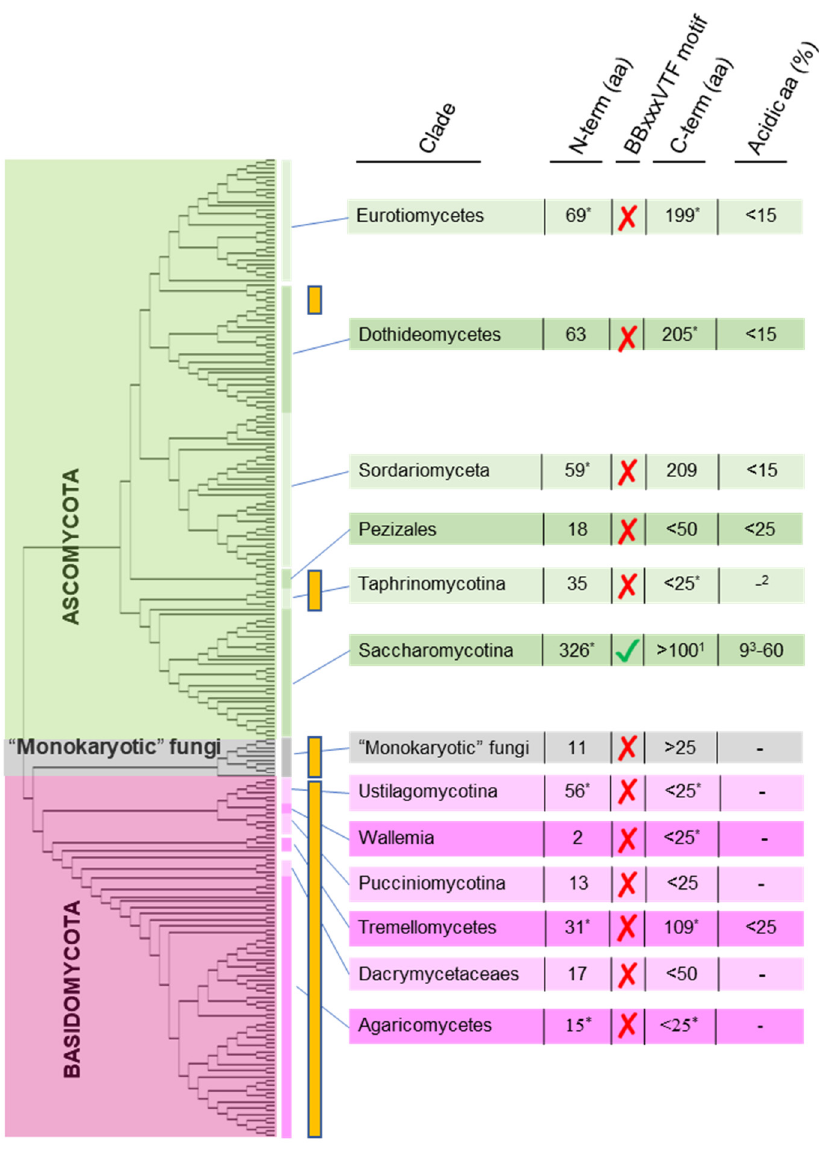
Figure 4. Structural features of Hal3/Cab3-like proteins in fungi. Phylogenetic tree of set of fungal species analyzed in [58]. The vertical orange bars denote clades with organisms with a monomeric PPCDC. The number of N- and C-terminal amino acids were calculated considering, as a central core, the cl19190 domain and excluding proteins in which other domains were identified in these extensions. The NCBI’s Batch Conserved Domain Search tool [59] was used to identify the location of the predicted domains in the output of the BLAST analysis for each specified family. Numbers in the figure indicate the average values. A threshold limit of at least 50 residues was required to cal- culate the percentage of acidic residues. (*), Clades including organisms with other domains identi- fied in the N- or C-terminal regions (not considered for calculation). (1) Heterogeneous values rang- ing from nine to 480 residues due to the values obtained in a few species included in the Trichospo- ronaceae family (see Table 1); (2) in the genus Schizosaccharomyces , these values range between 43 and 60% when the residues included in the thymidylate synthase domain were not considered as a C-terminal extension. (3) The lowest range limit is due to the few members of the Trichosporonaceae family (see Table 1).